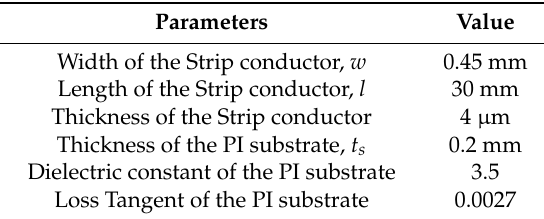
Figure 1. The structure of the laser-scribed MS line. w , l , and t s are the width of the strip conductor, the length of the strip conductor, and the thickness of the polyimide substrate, respectively. Table 1. The parameters of the 50 Ω MS line